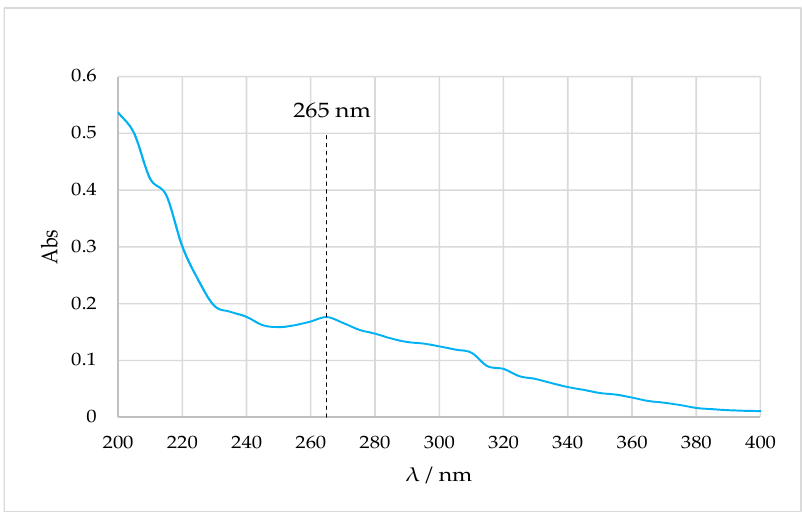
Figure 2. Absorption curve of immortelle EO, range 400–200 nm.